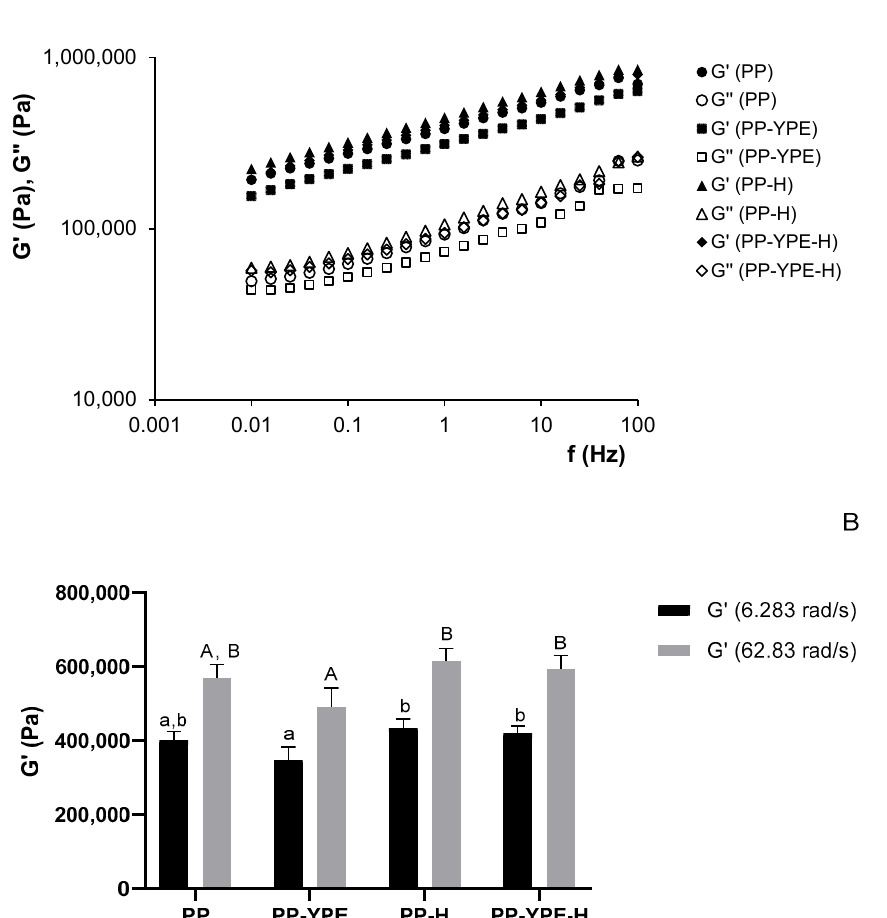
Figure 3. Mechanical spectra obtained for pear pomace (PP), pear pomace enriched with YPE (10% w / w ) (PP-YPE), heated pear pomace (PP-H) and heated pear pomace enriched with YPE (10% w / w ) (PP-YPE-H). G ′ (storage modulus—filled symbol) and G ′′ (loss modulus—open symbol) ( A ). Values of G ′ at 1 Hz (6.283 rad/s) and 10 Hz (62.83 rad/s) obtained for each sample ( B ). Results are presented as mean ± standard deviation. Columns with different letters (uppercase or lowercase), are statistically different ( p < 0.05).